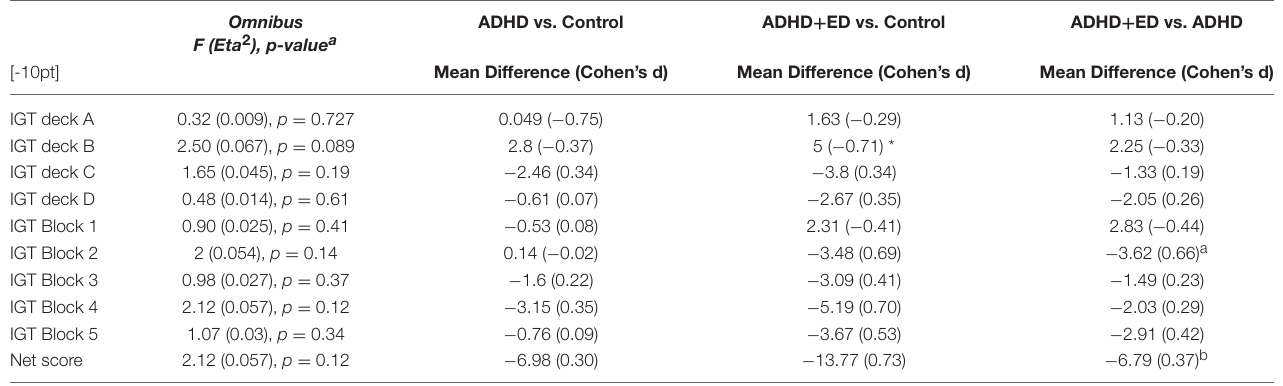
TABLE 4 | Interactions among groups for Iowa gambling task.